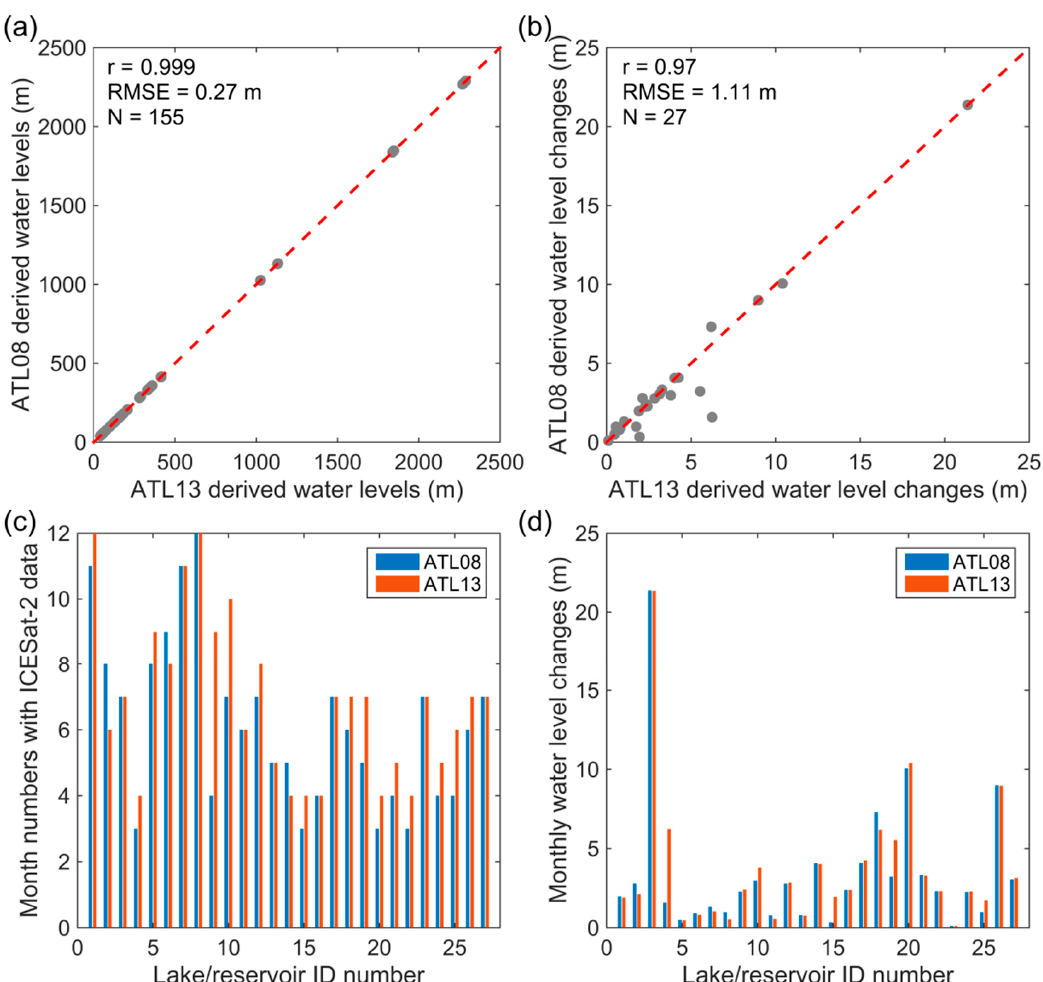
Figure 9. Summary of comparisons between monthly water levels in 2019 from our ATL13 ‐ derived results and another ATL08 ‐ derived results [28] of 16 lakes/reservoirs in the United States (ID: 1–16) and 11 lakes/reservoirs in Australia (ID: 17–27). The lake/reservoir ID numbers are consistent with those in Figure 6. In ( a , b ), red dash lines represent 1:1 lines of scatter plots. In ( a ), N (i.e., 155) represents the number of months with both available ATL13 and ATL08 products of 27 lakes/reservoirs in the United States and Australia, i.e., for each lake/reservoir, the mean number of months with both available ATL13 and ATL08 products is approximately 6 months within a year. In ( b ), N (i.e., 27) represents the number of lakes/reservoirs in this comparison in the United States and Australia.